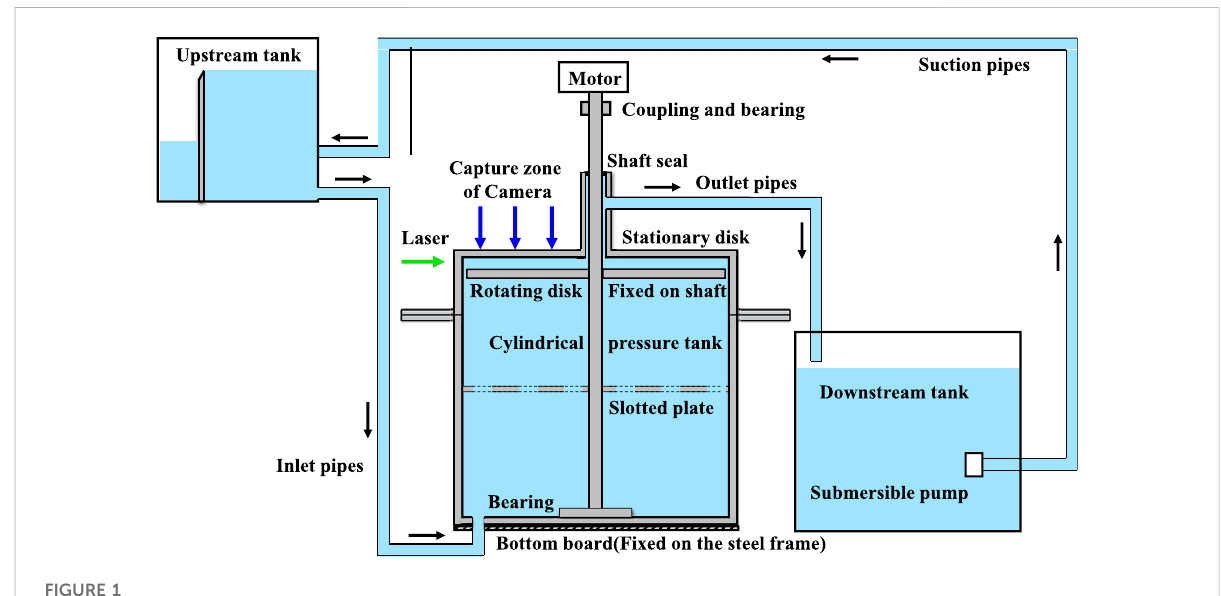
FIGURE 1 Testing setup of the rotating – stationary disk model